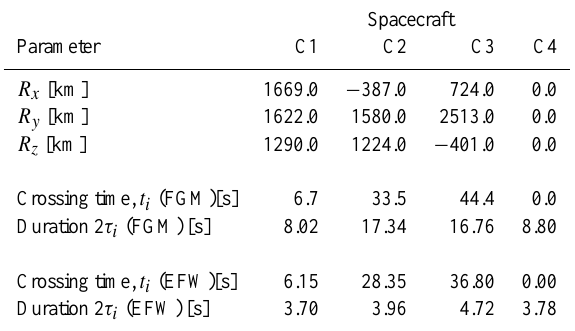
Table 2. Separation distances, R i , (GSE), crossing durations, 2 τ i , and center crossing times, t i , relative to the the C4